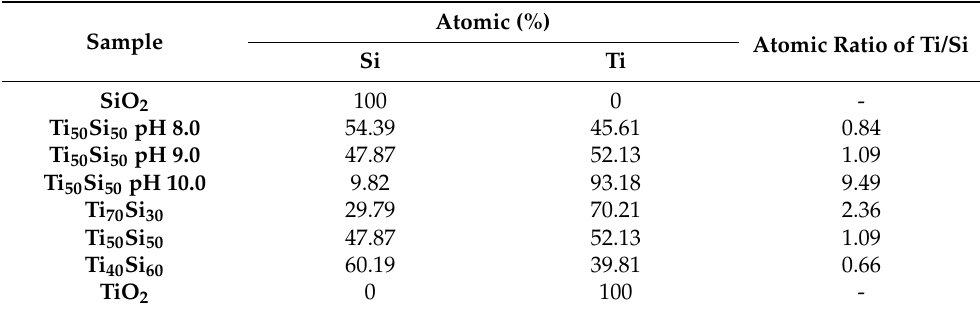
Table 4. Percentage of atomic and atomic ratio of Ti and Si in TiO 2 , SiO 2 , and Ti 50 Si 50 oxide synthe- sized at various pH values and Ti x Si y oxide synthesized at pH 9.0 with different Ti/Si ratios.